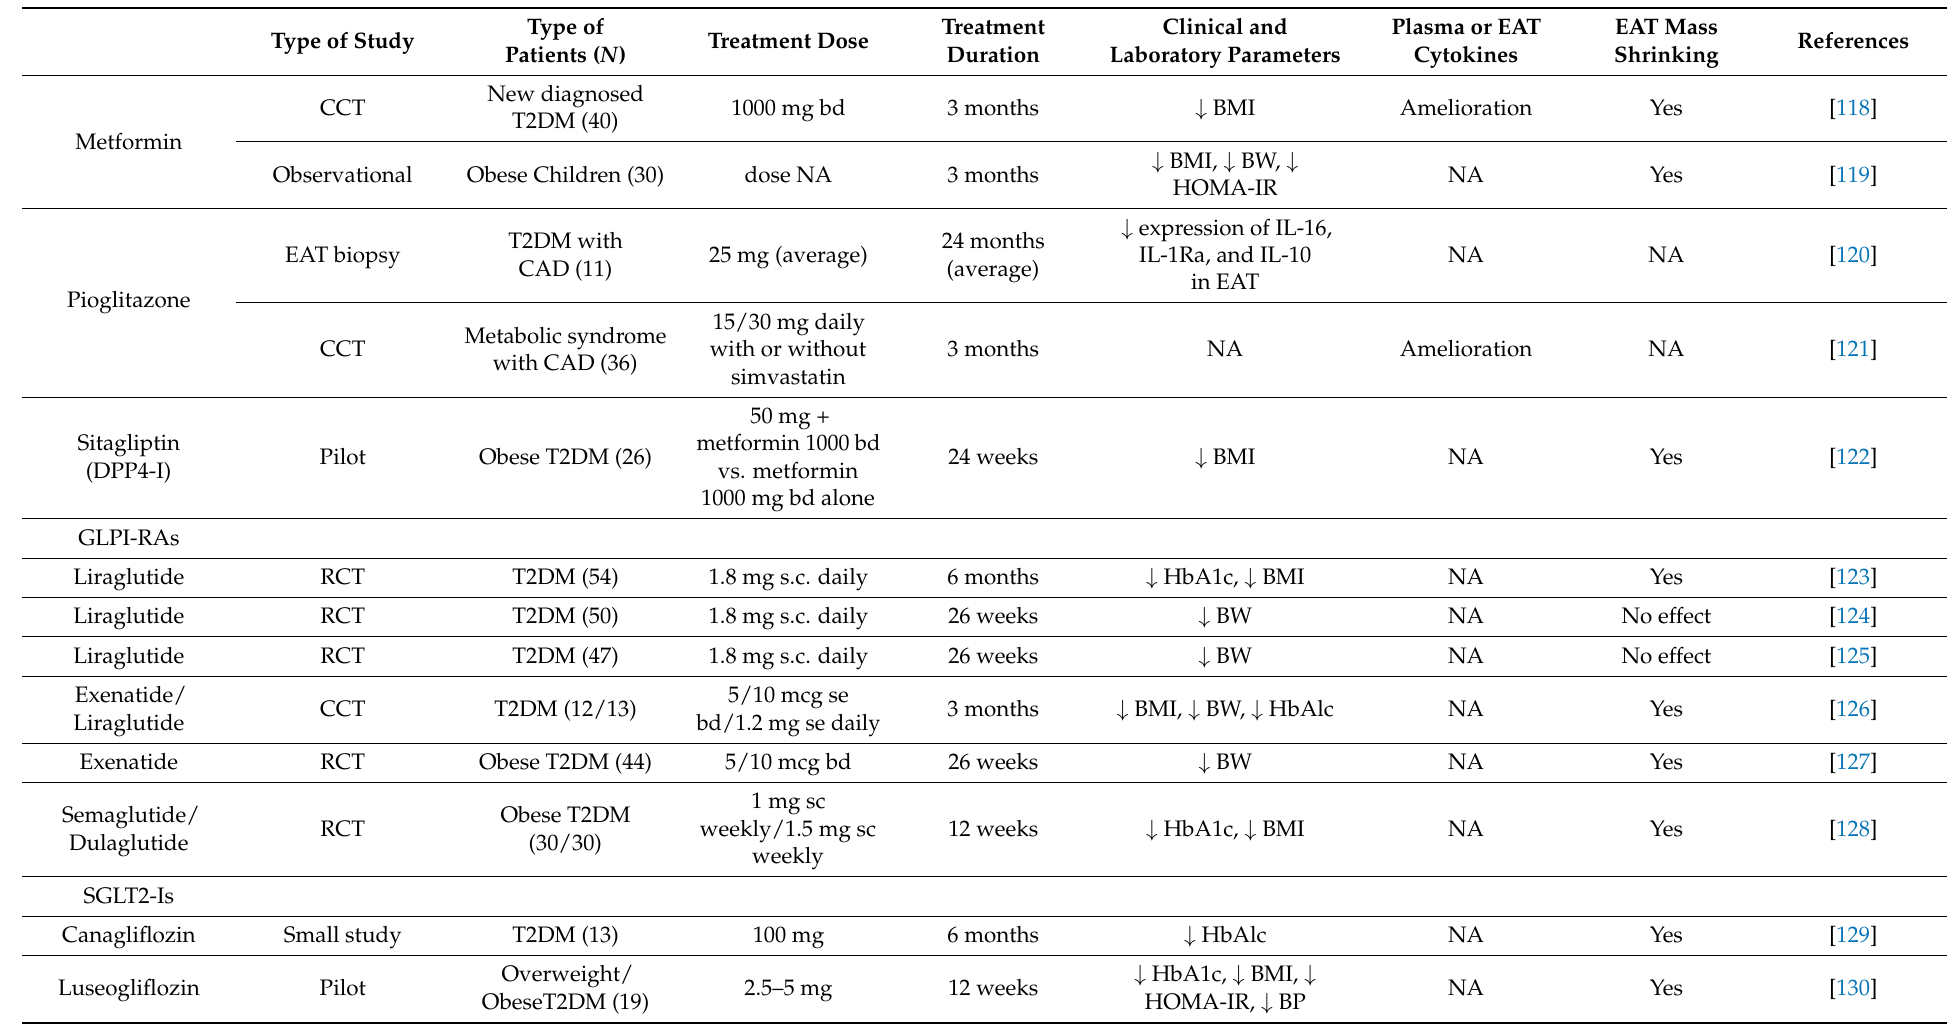
Table 1. Effects of glucose-lowering drugs on EAT in clinical studies. No reported study evaluated HFpEF or other CV